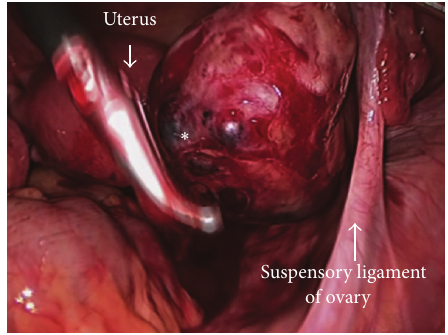
Figure 2: Laparoscopic image demonstrates an ectopic GS ( ∗ ) incarcerated to the posterior surface of the right ovary.